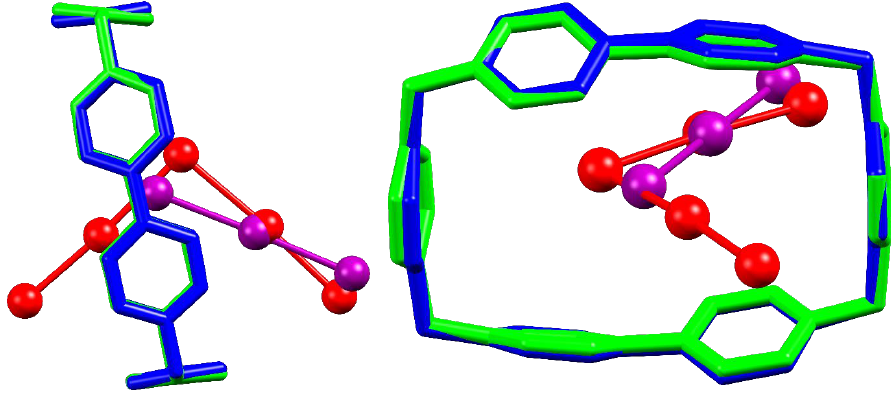
Figure 6. Side and front comparisons of host-guest interaction for BB ... I 3 in I 3 @BB(I 3 ) 3 · 2DMSO (blue and violet) and BB ... I 5 − in I 5 @(BB)(I 3 ) 3 (green and red). Superimposition is obtained by overlap of the four C atoms of BB methylenic corners (RMS = 0.0617).